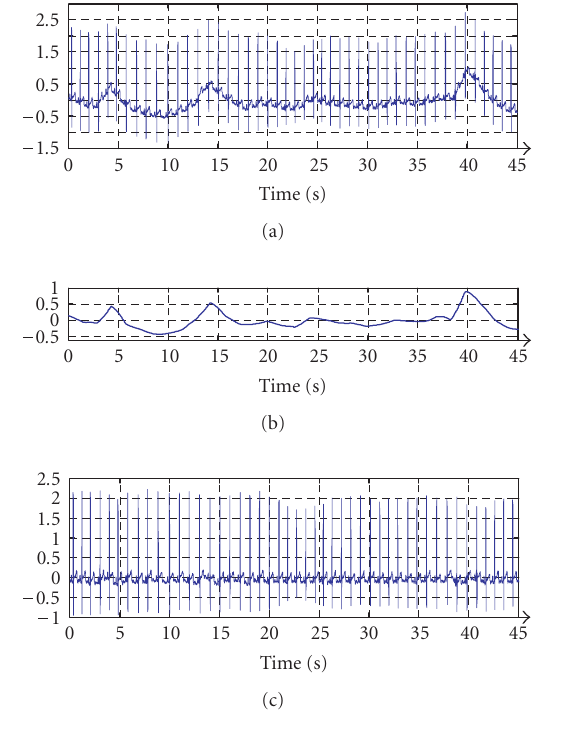
Figure 8: The ECG record “b115-1,” (a) original ECG signal, (b) estimated baseline drift, (c) ECG after removing the baseline.